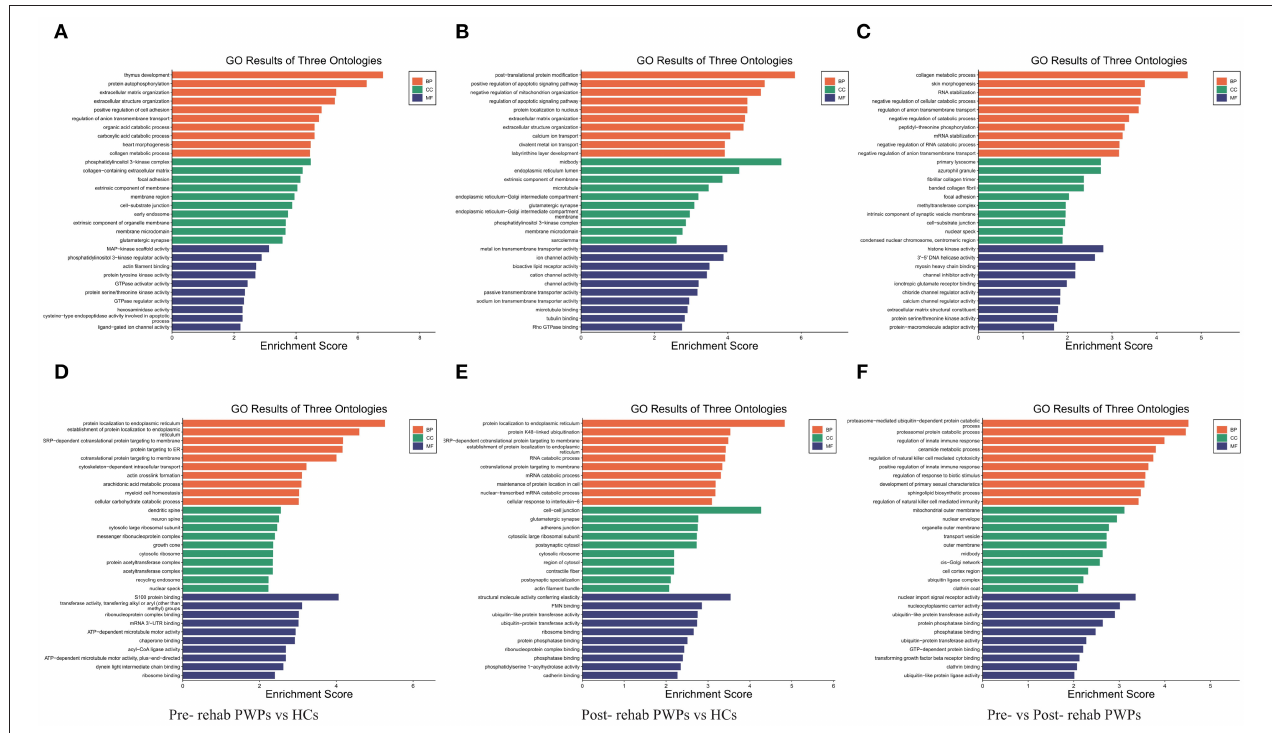
FIGURE 4 | GO analysis of differentially expressed genes. GO analysis of upregulated (A) and downregulated (D) mRNAs between Pre-rehab PWPs and HCs. GO analysis of upregulated (B) and downregulated (E) mRNAs between Post-rehab PWPs and HCs. GO analysis of upregulated (C) and downregulated (F) mRNAs between Pre- and Post-rehab PWPs. Pre-rehab, pre- rehabilitation; Post-rehab, post-rehabilitation; PWPs, patients with Parkinson’s disease; GO, gene ontology; BP, biological process, MF, molecular function, CC, cellular